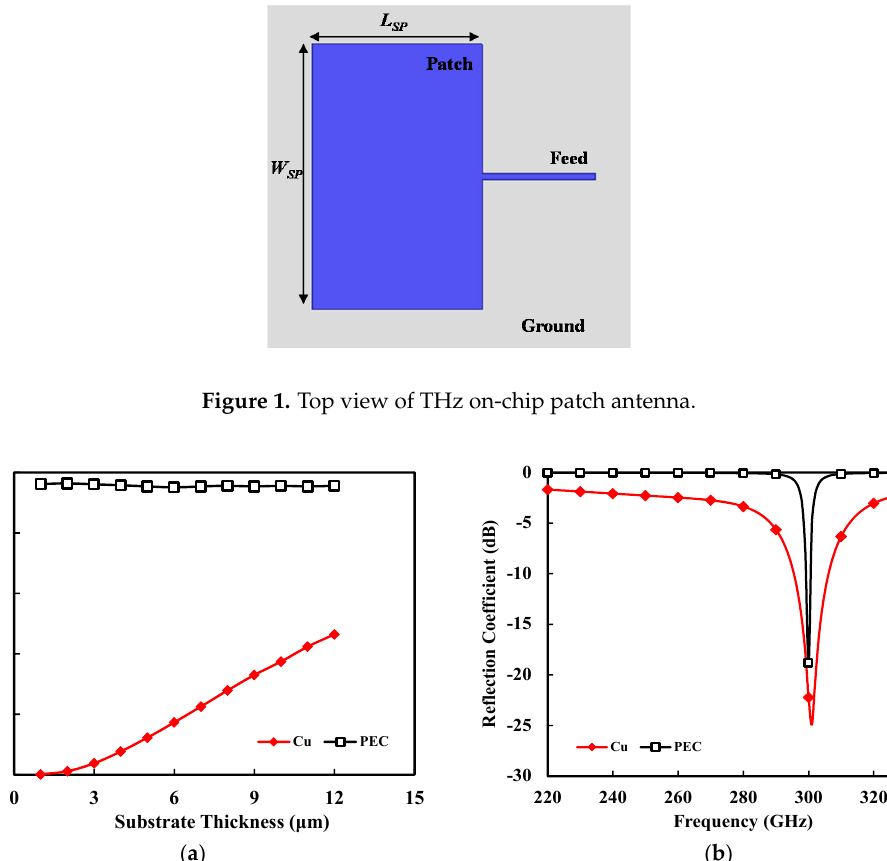
Figure 2. Simulation of the standard CMOS patch antenna. ( a ) Radiation efficiency according to substrate thickness (at a fixed frequency of 300 GHz). ( b ) Reflection coefficient (| S 11 |) with frequency ( W SP = 345 μ m, L SP = 225 μ m, and substrate thickness of 4.49 μ m).